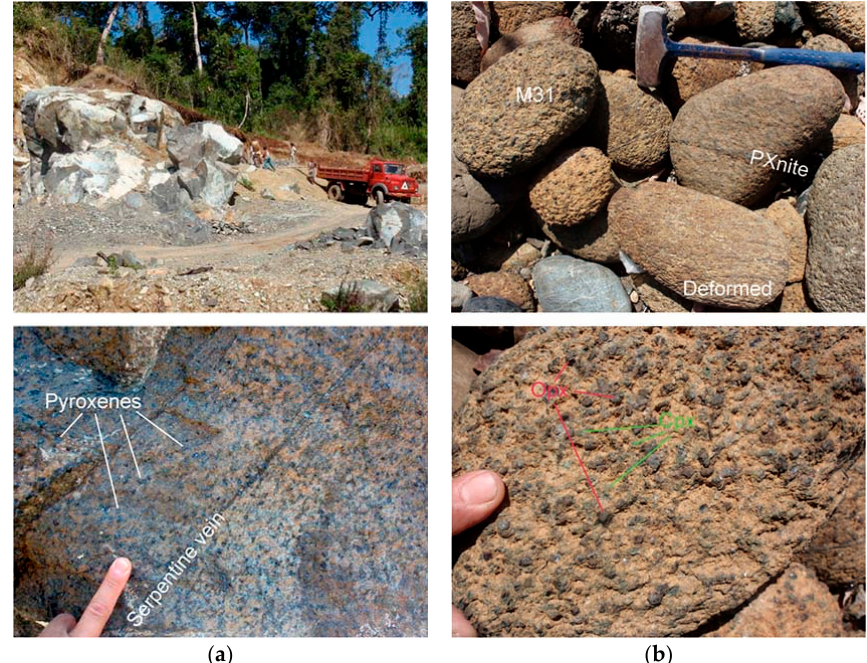
Figure 2. ( a ) Upper, massive lherzolite exposure in a quarry (location of M21). Lower, close-up of M21. ( b ) Upper, pyroxene-rich peridotite boulders along the cost. The studied M31. Lower, close-up of M31. Emerald green clinopyroxene (Cpx) and relatively dark orthopyroxene (Opx) are visible on weathered surface ( b ).